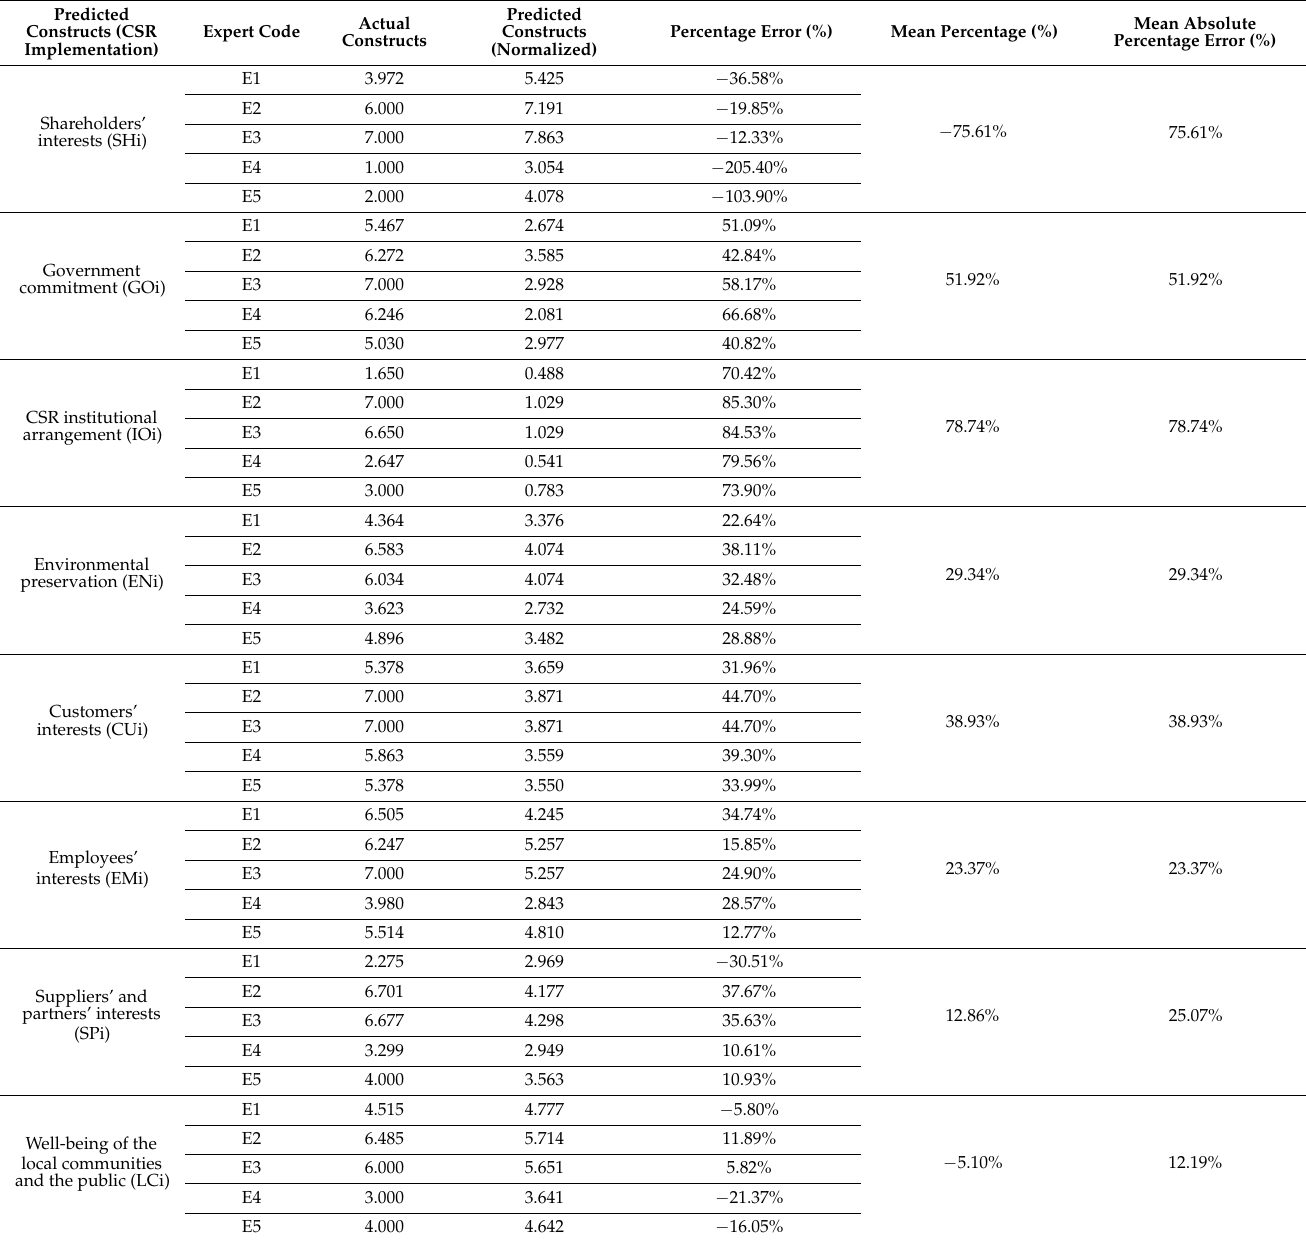
Table 2. Comparison of actual and normalized predicted